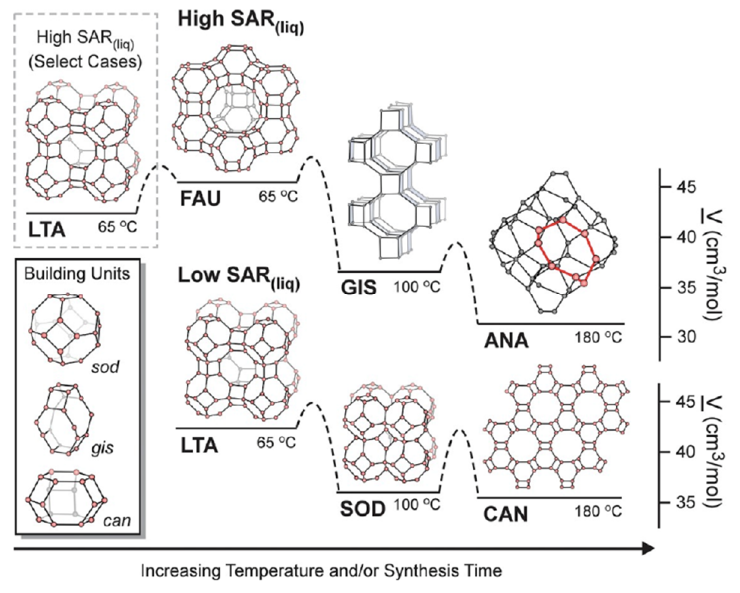
Figure 9. Stages of Na-zeolite phase transformation with increasing synthesis temperature and time. (adapted from [44]).